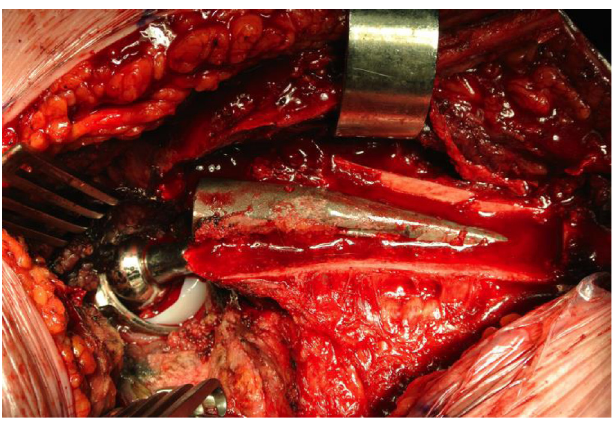
Figure 3. ETO performed to remove a well fi xed femoral component implanted in excessive retroversion.